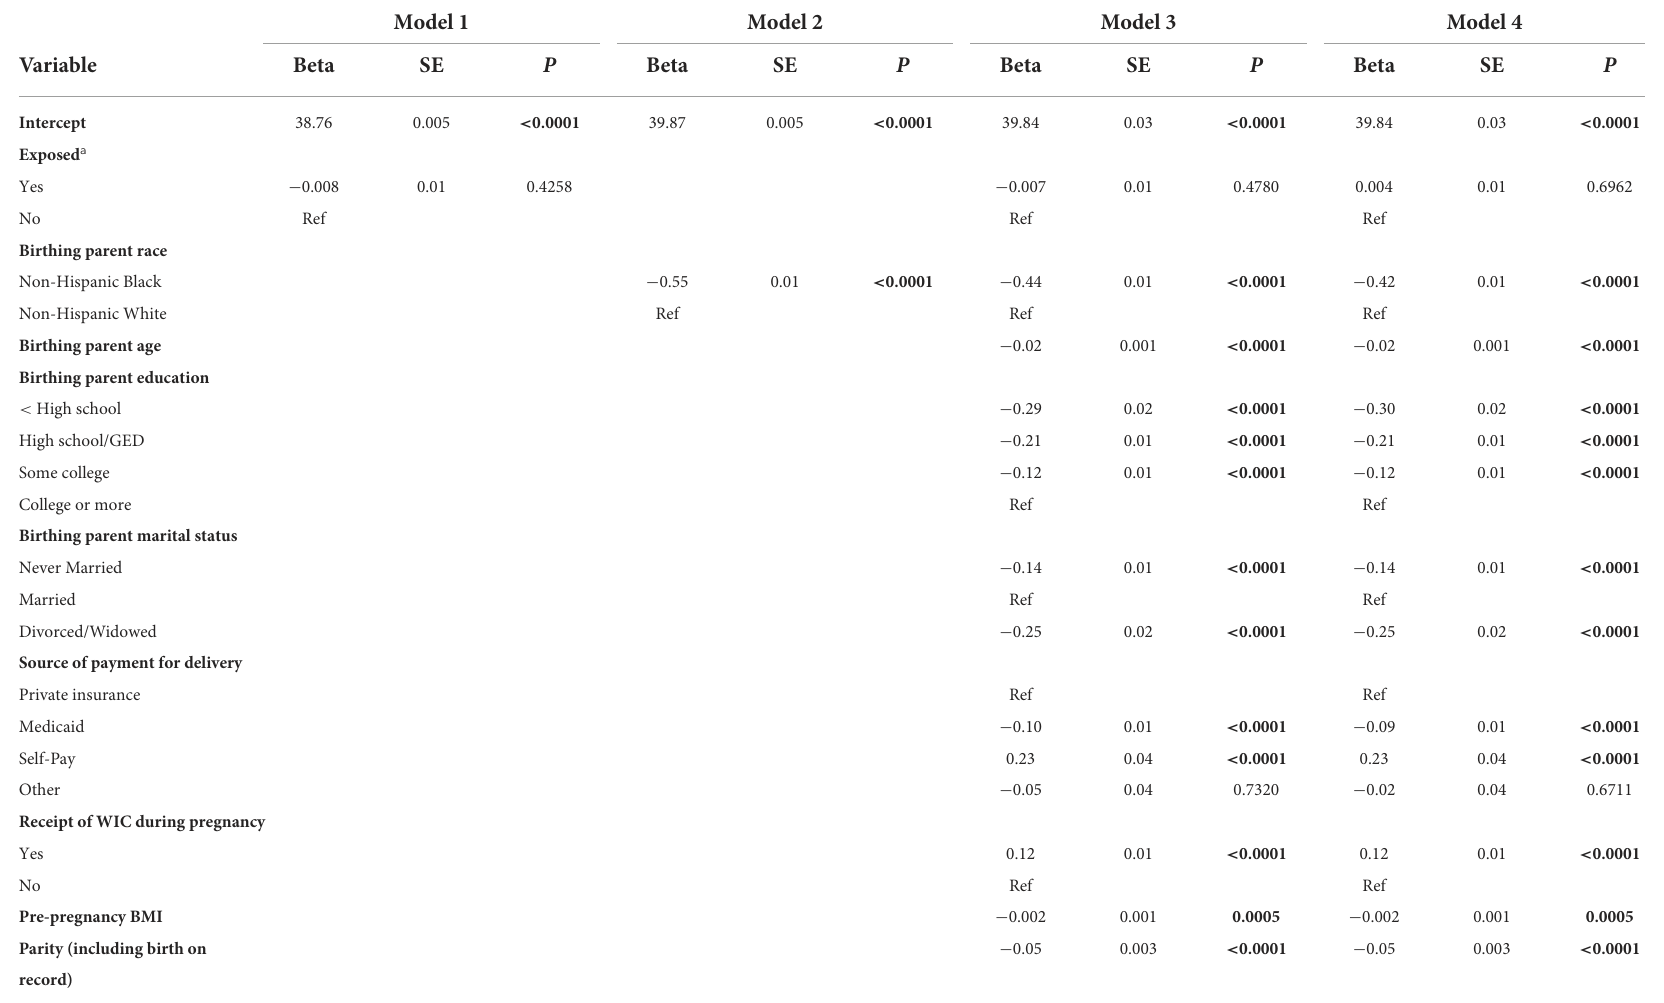
TABLE 3 Linear regression coefficients for regression of gestational age (weeks) on exposure to the Flint Water Crisis emergency declaration in Michigan ( n =